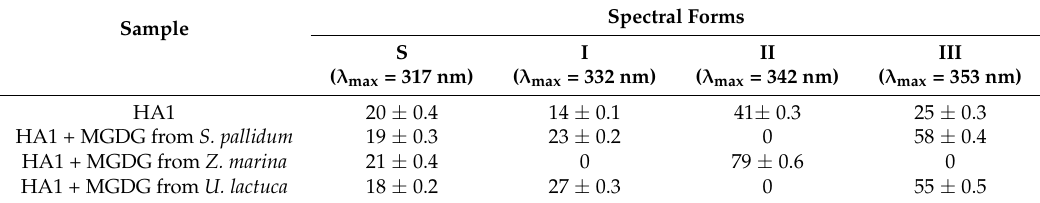
Figure 4. Intrinsic fluorescence spectra (symbols) of HA1 alone ( a ) and in complex with the monogalactosyldicylglycerol (MGDG) from Sargassum pallidum ( b ), Zostera marina ( c ), or Ulva lactuca ( d ) in PBS, pH 7.4, and their fit to the theoretical model of discrete states of tryptophan residues in proteins [16] (solid lines) which are the sums of the spectral components S, I, II, and III (dashed lines). The protein concentration was 0.05 mg/mL. The excitation wavelength was 296 nm. Table 2. Influence of monogalactosyldicylglycerol (MGDG) from marine macrophytes on the contribution of tryptophan spectral forms to the total fluorescence spectrum of HA1, %.